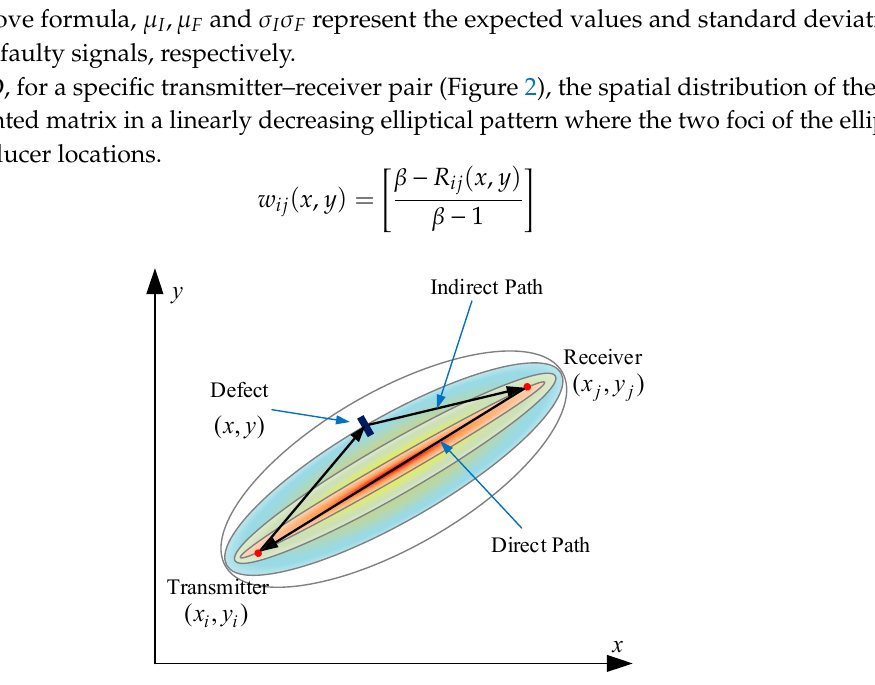
Figure 2. Graphical description of crack identification.